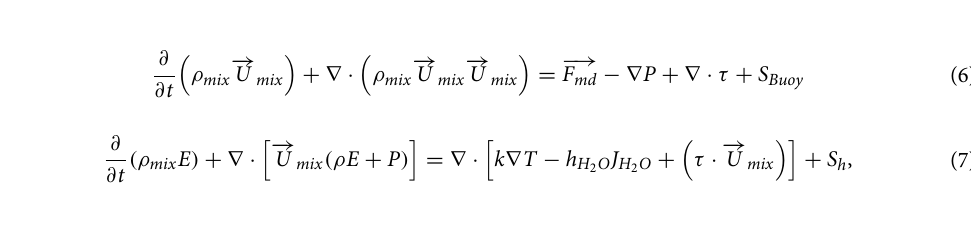
Figure 10. Sectional saliva droplets size distribution (intercepting from 1 to 10